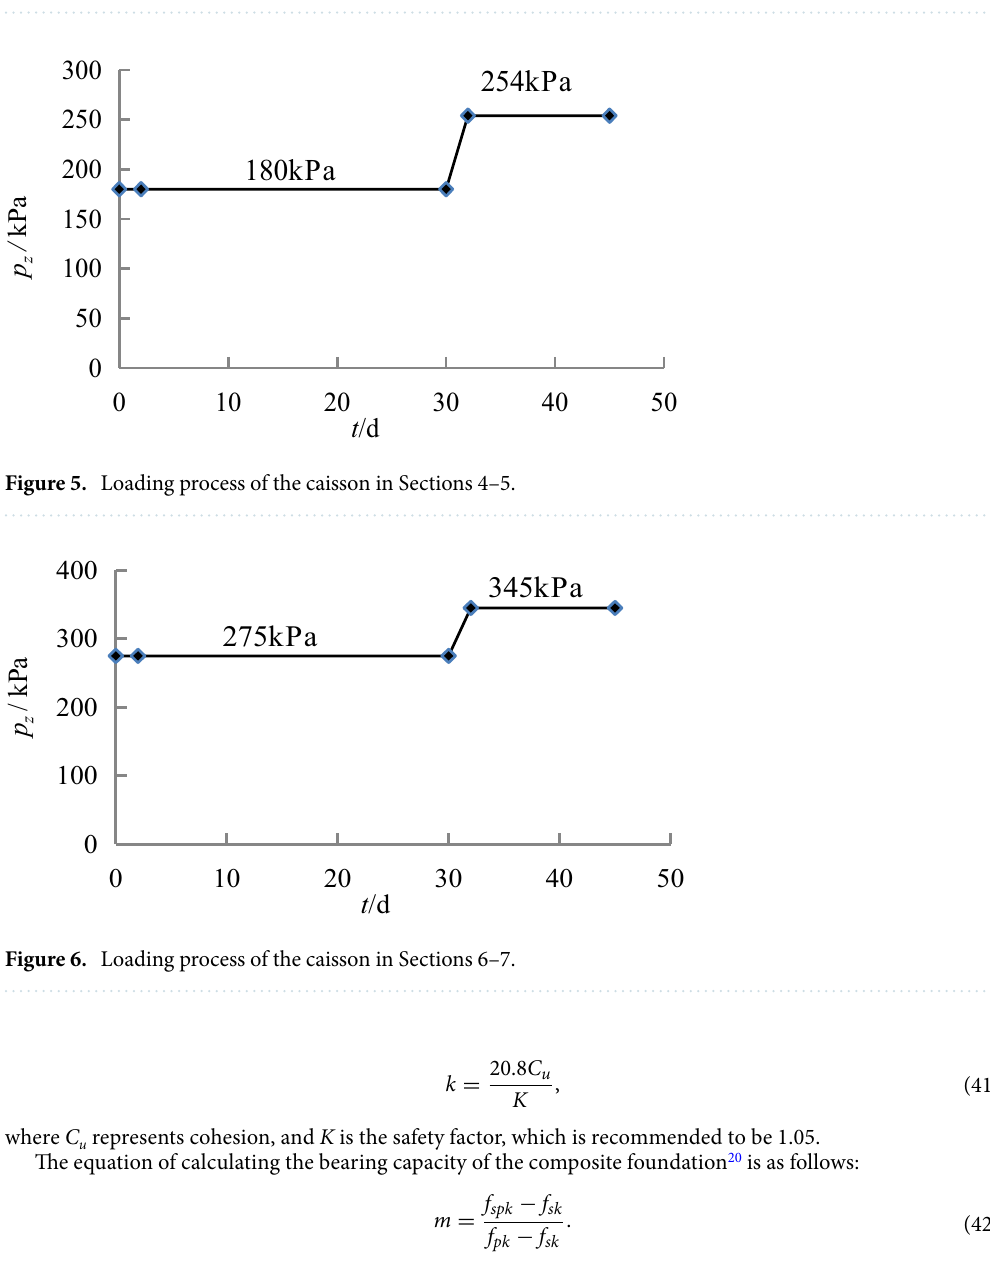
Figure 4. Loading process of the caisson in Sections 1–3.